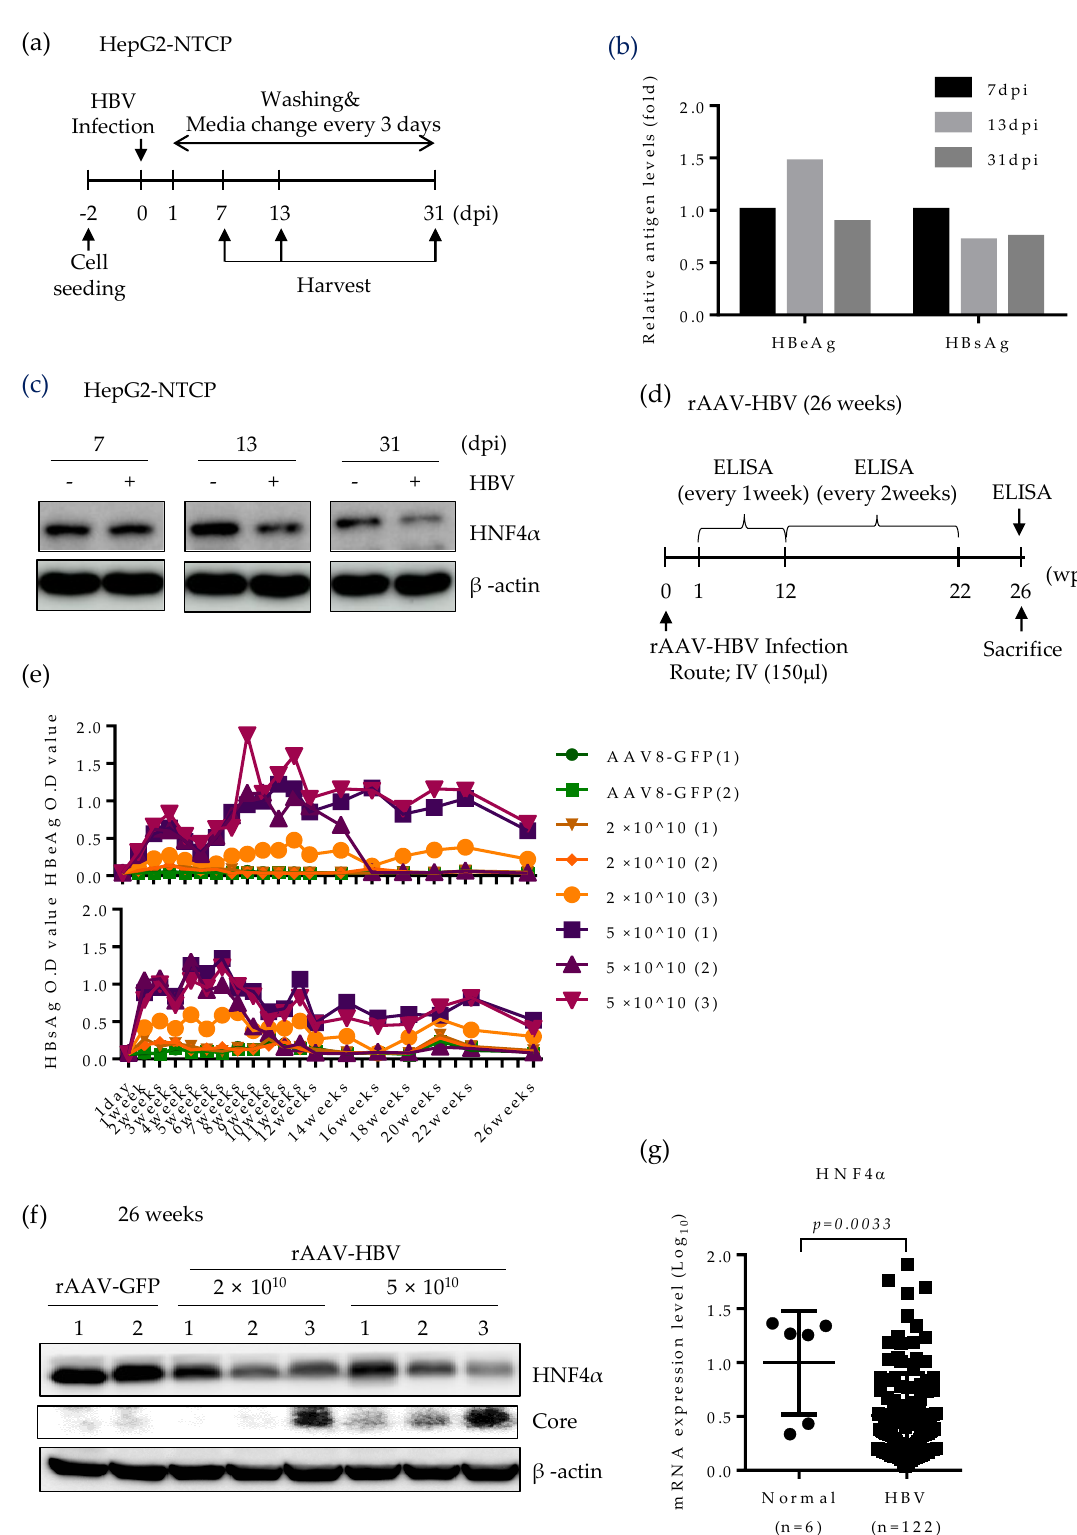
Figure 5. HNF4 α expression is suppressed following long-term HBV infection in vitro and in vivo mouse model. ( a ) HepG2-NTCP cells were infected with cell culture derived HBV at 2000 GEq / cell. Cells were maintained in culture medium containing 2.5% DMSO and were harvested at the indicated time points. ( b ) Secreted HBsAg and HBeAg were quantified by immunoassay. ( c ) HNF4 α protein level was analyzed by Western blotting. The data represent the results from three independent